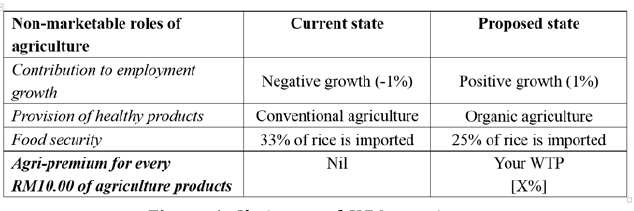
Figure 1: Choice set of CVM question